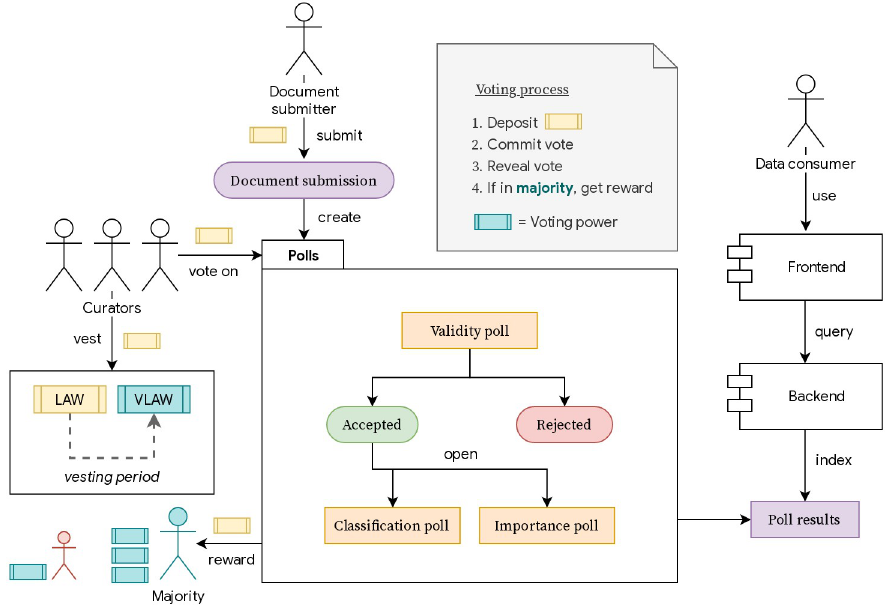
Fig 1. Components and actors. Functional components and actors in the AnyCase